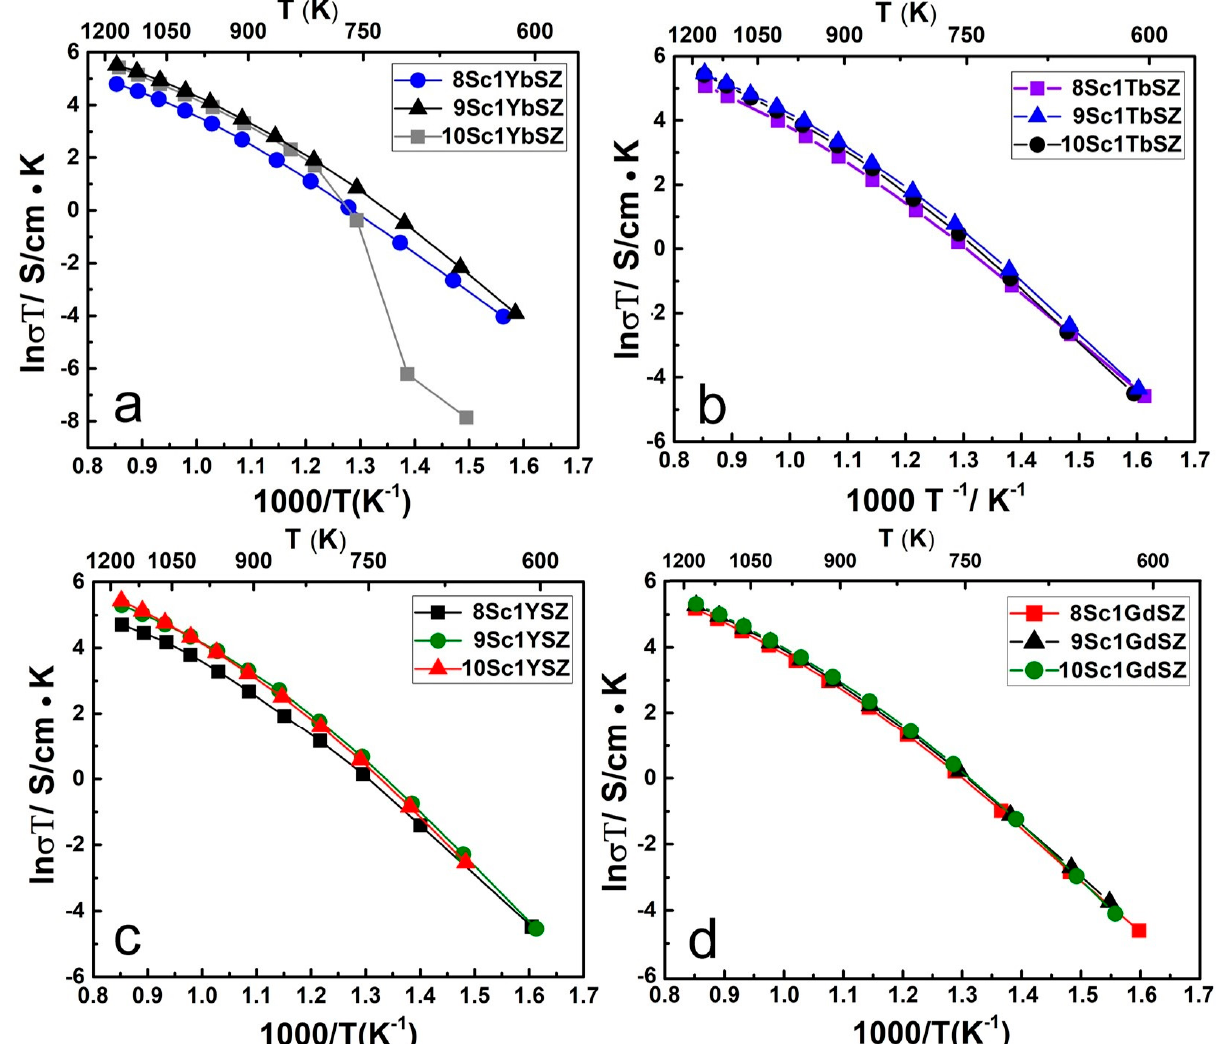
Figure 5. Temperature dependences of the electrical conductivity of crystals (ZrO 2 ) 0.99 − x (Sc 2 O 3 ) x (Yb 2 O 3 ) 0.01 ( a